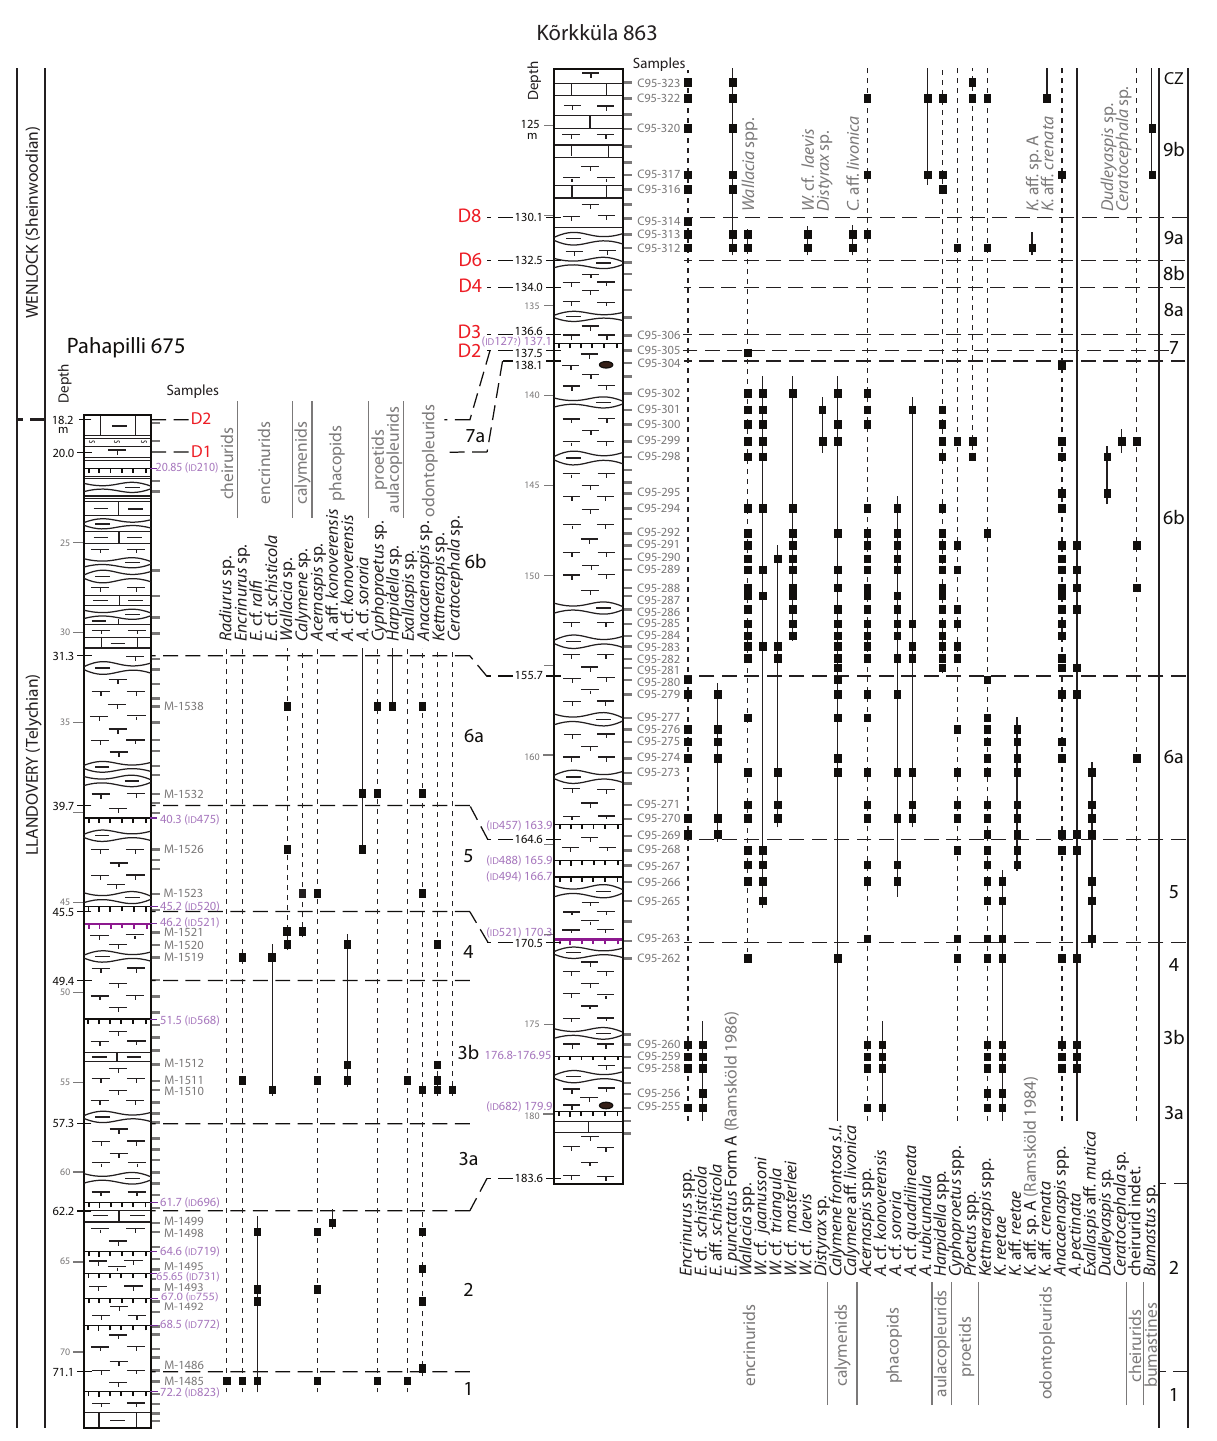
Fig. 7. Distribution of trilobites in the Pahapilli 675 and Kõrkküla 863 sections. ID numbers next to the logs mark the volcanic ash beds (see Kallaste and Kiipli 2006). For the legend and explanation of indexes, see Figs 2 and